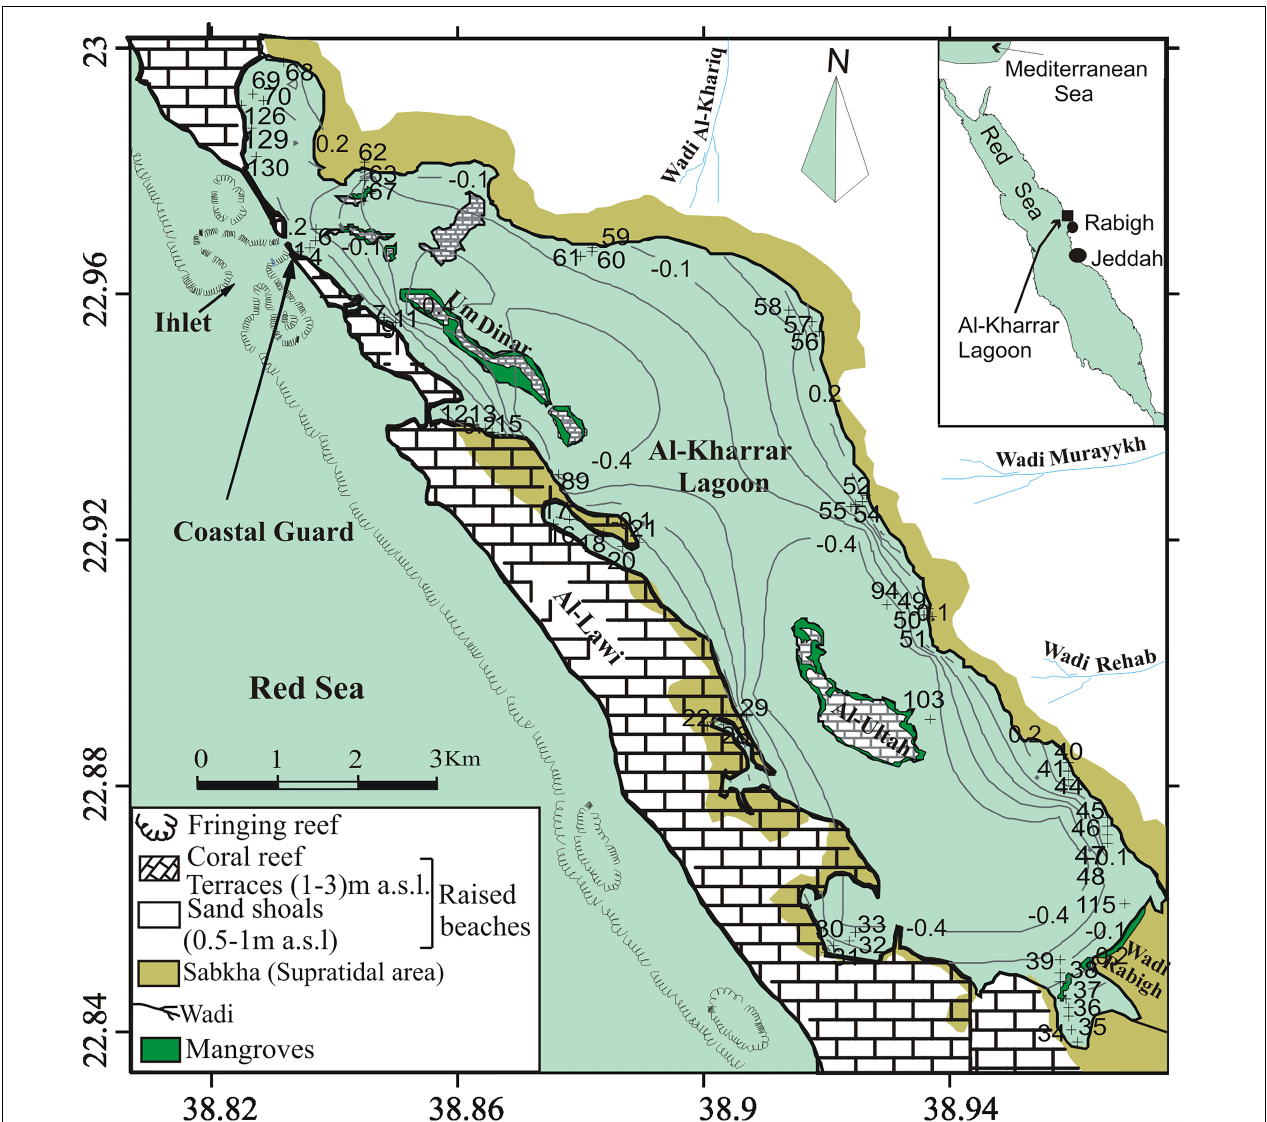
FIGURE 1 | Location map of supratidal–intertidal sabkha, surface sediment sample sites (transects) and elevations in the Al-Kharrar Lagoon during March 2014 (modified after Al-Dubai et al.,